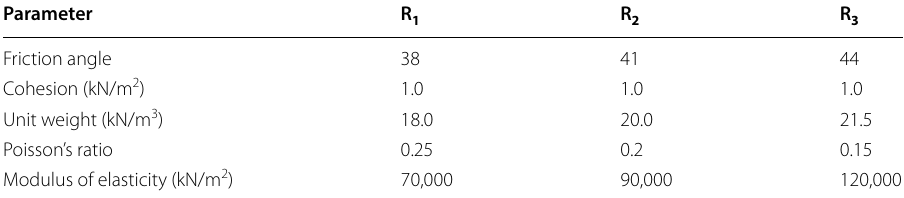
Table 4 Sand properties for numerical